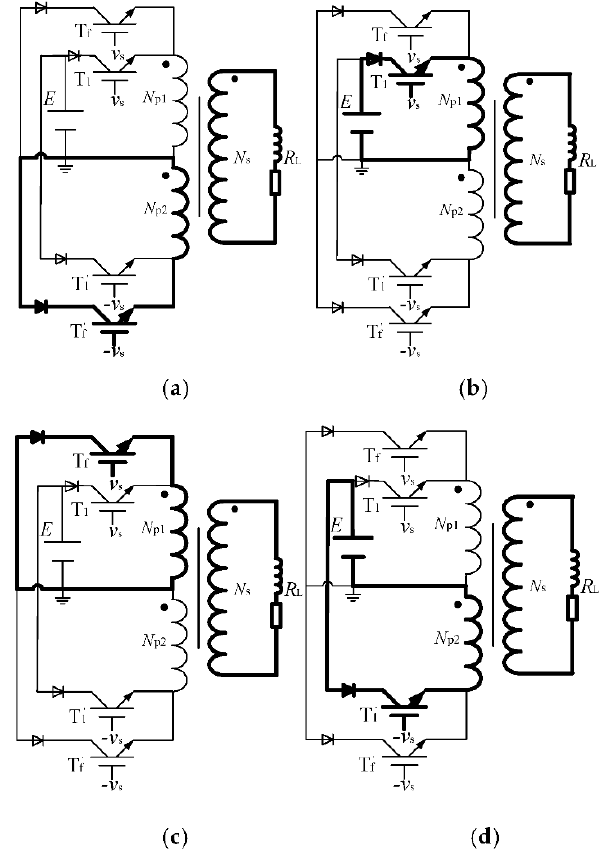
Figure 4. Decomposition of working process of power converter. ( a ) Positive voltage, negative current. ( b ) Positive voltage, positive current. ( c ) Negative voltage, positive current. ( d ) Negative voltage, negative current.